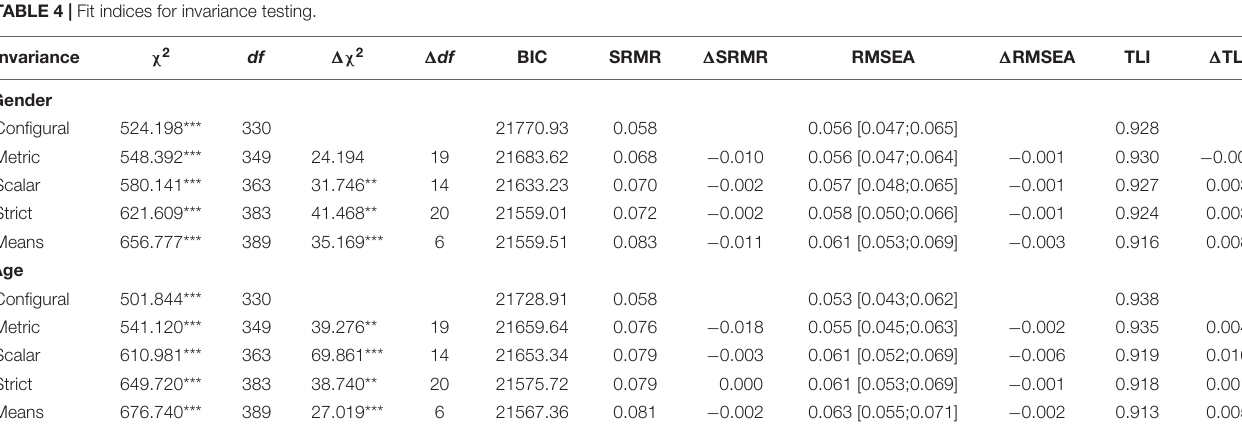
FIGURE 2 | The hierarchical model, χ 2(165) = 317.656, p < 0.001, BIC = 21537.633, SRMR = 0.05, RMSEA = 0.051, TLI = 0.942. TABLE 4 | Fit indices for invariance testing.